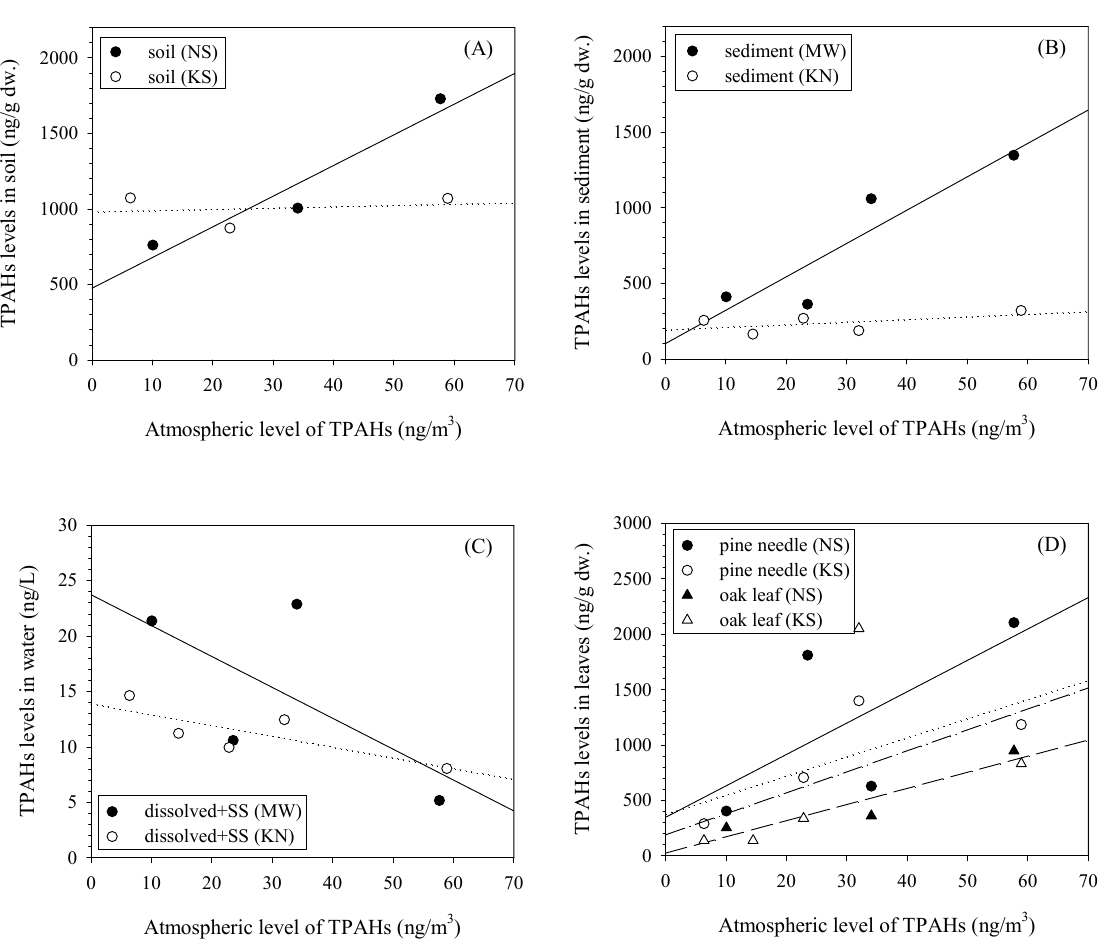
Figure 5. Correlation of atmospheric level of TPAHs (gas + particulates) with that in (A) soil, (B) water (dissolved + suspended solids), (C) sediment, and (D) leaves. TPAHs is the sum of 15 PAHs (PH~DA of MW > 178 in Table 2) for air and water and the sum of all 24 PAHs for the